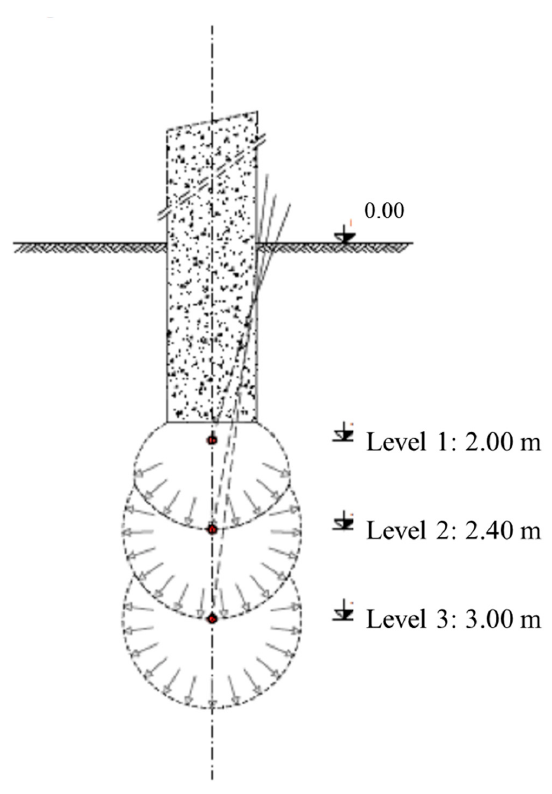
Figure 6. Treatment levels along the building’s foundation walls.